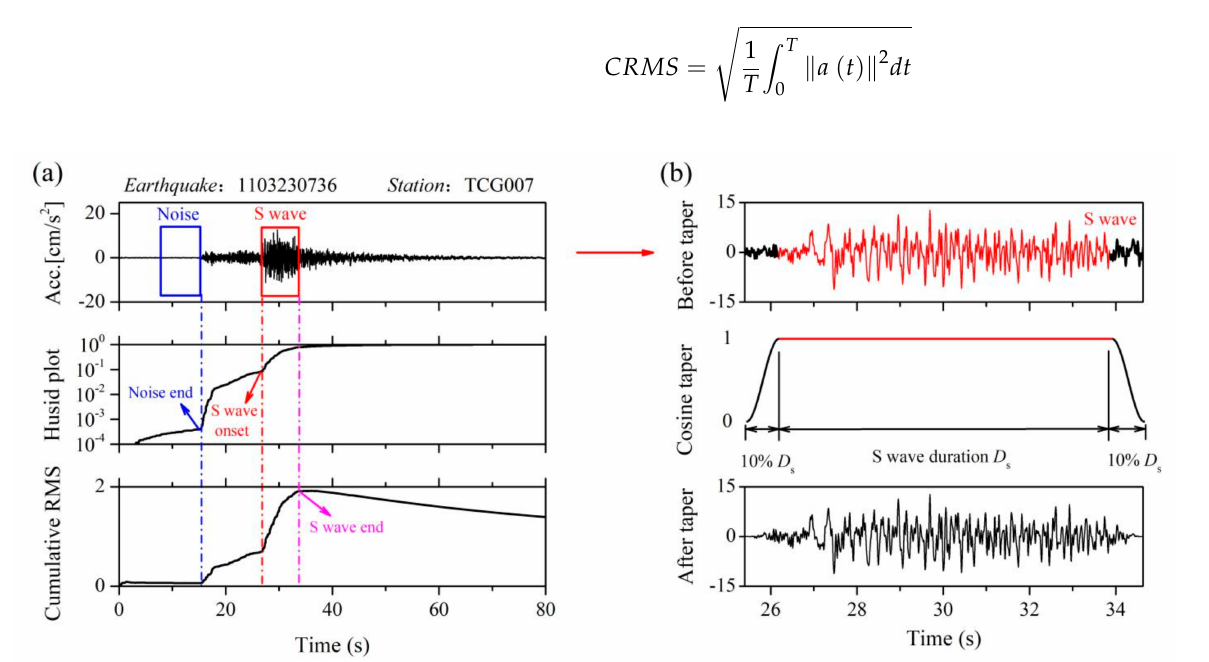
Figure 2. ( a ) An example illustrating how to extract the S wave signal and the pre-P wave noise window according to the Husid plot and the cumulative RMS function. ( b ) The example of how to add cosine windows at the beginning and end of the seismic